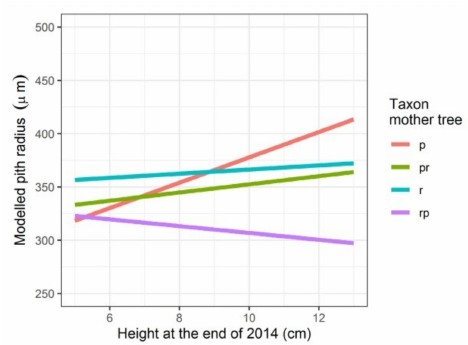
Figure 2. Modelled pith radius depending on the height the seedlings attained in the first growing season and on the taxon of the mother tree. p: Q. petraea , pr: long stalked intermediate, r: Q. robur , rp: short-stalked